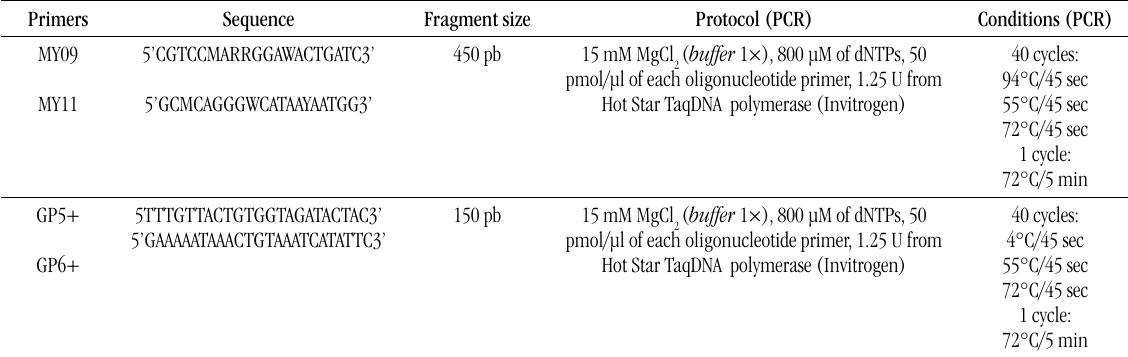
tABLE 1 – Genetic oligonucleotide primers used for DNA of HPV